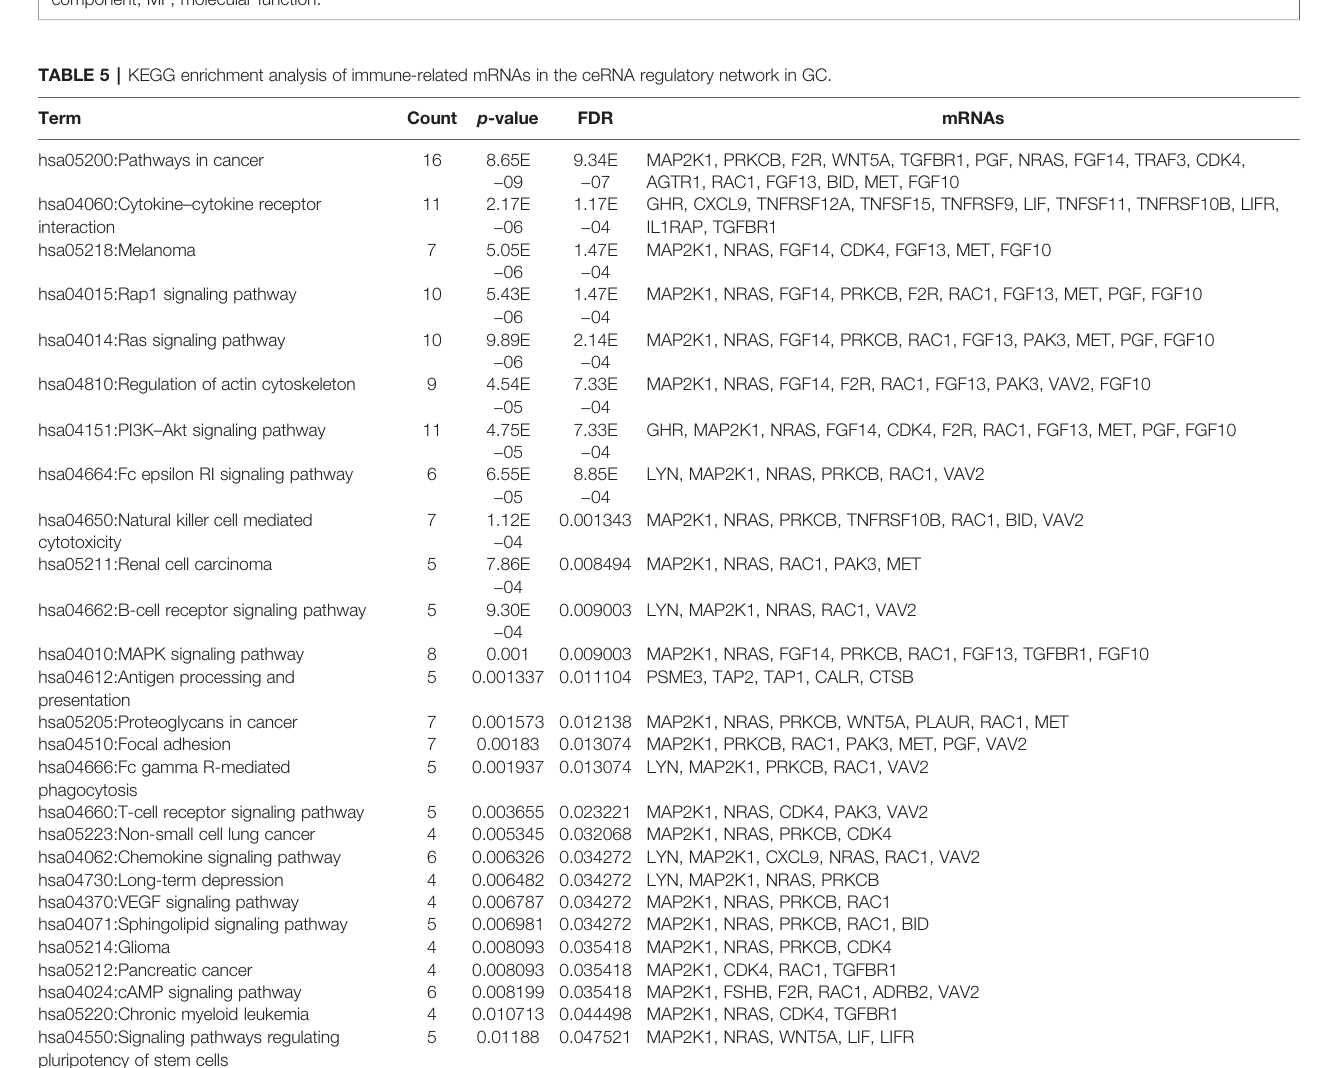
FIGURE 4 | GO (A) and KEGG (B) enrichment analyses of immune-related mRNAs in the regulatory ceRNA network in GC. BP, biological process; CC, cytological component; MF, molecular function.